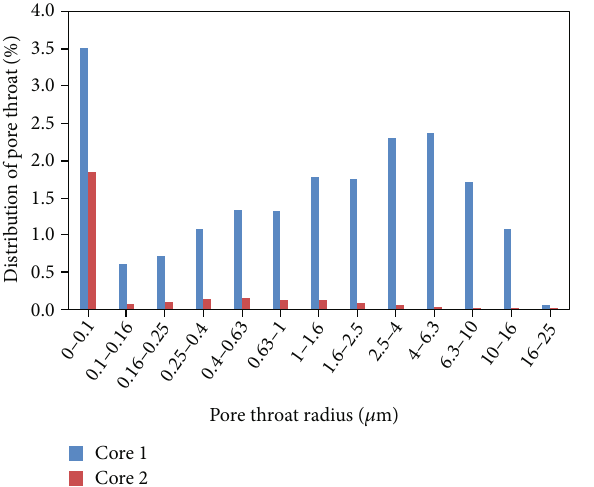
Figure 2: The pore-throat distribution of the core.